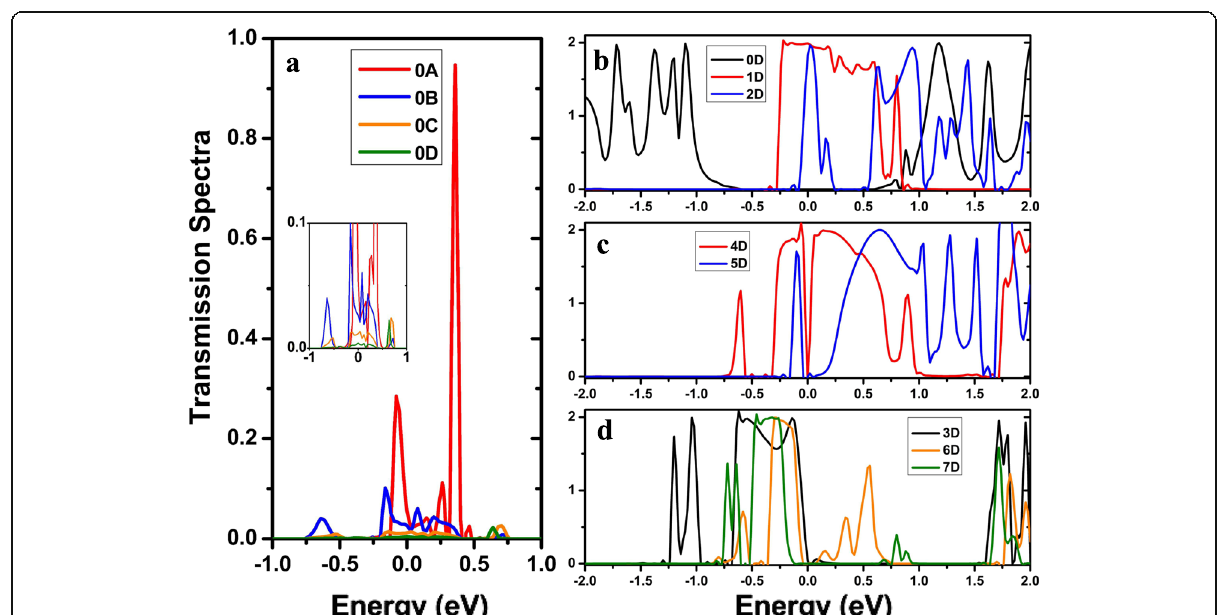
Fig. 5 (Color online) The calculated transmission spectra of A γ GYNRs at zero bias a without or b – d with various N-doping models in the horizontal molecular nanowires, where the corresponding repeated unit cell is displayed at Fig. 1. a The transmission spectra for non-doping A γ GYNRs for M 0 including four molecular chains with different molecular lengths for A – D; the color of solid lines in the figure is consistent with that in Fig. 2a. The inset is the partly blow-up view of the main view where the transmission spectrum is less than 0.1. Similarly, the solid lines in b are consistent with those lines with common colors in Fig. 2d for M 0D – M 2D , and the solid lines in c / d correspond to the ones in Fig. 2e for M 3D – M 7D ,